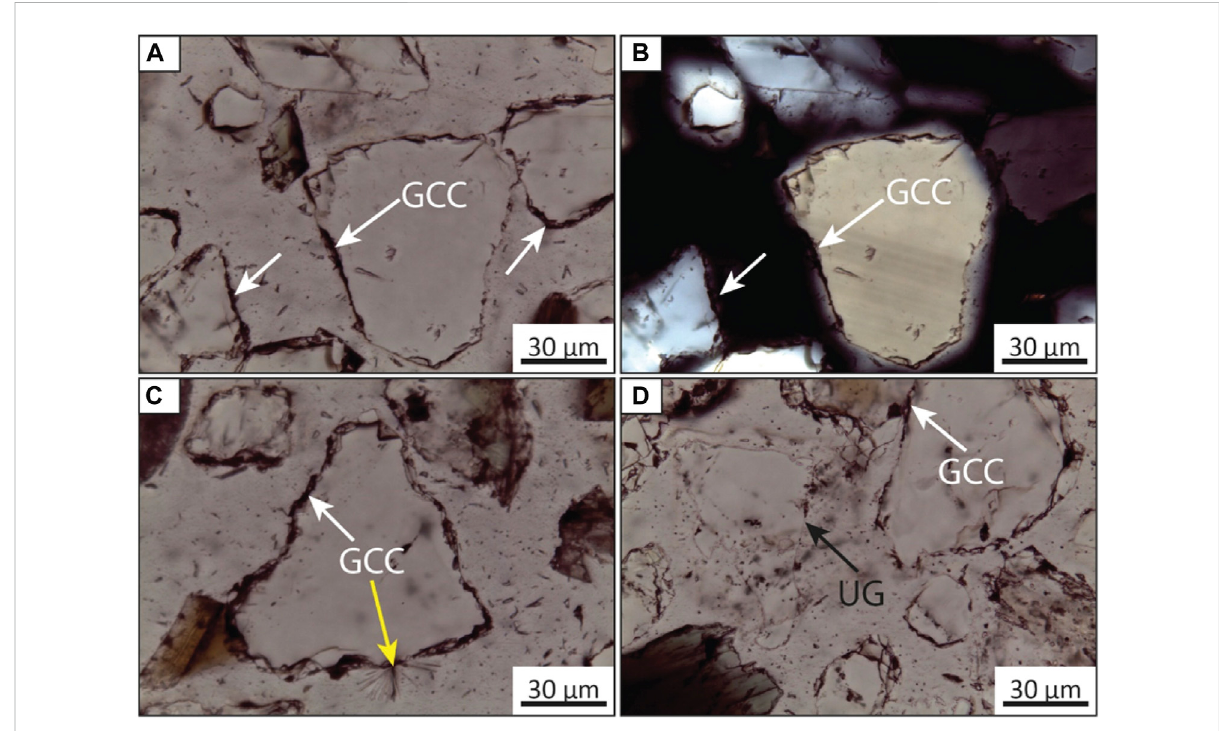
FIGURE 9 High-resolution,thin-section photomicrographsofgrain-coatingchlorite. (A) Planepolarizedlight(PPL)imageofgrain-coatingchlorite(GCC) on detrital grains showing largely continuous coat. (B) Cross-polarized light (XPL) image of (A) . (C) Well-developed grain-coating chlorite (GCC) on detrital quartz, growing both parallel (white arrow) and perpendicular to grain surface (yellow arrow). (D) Plane polarized light (PPL) image showing coated and uncoated detrital grains (UG). Note that these images were from the reacted Sample